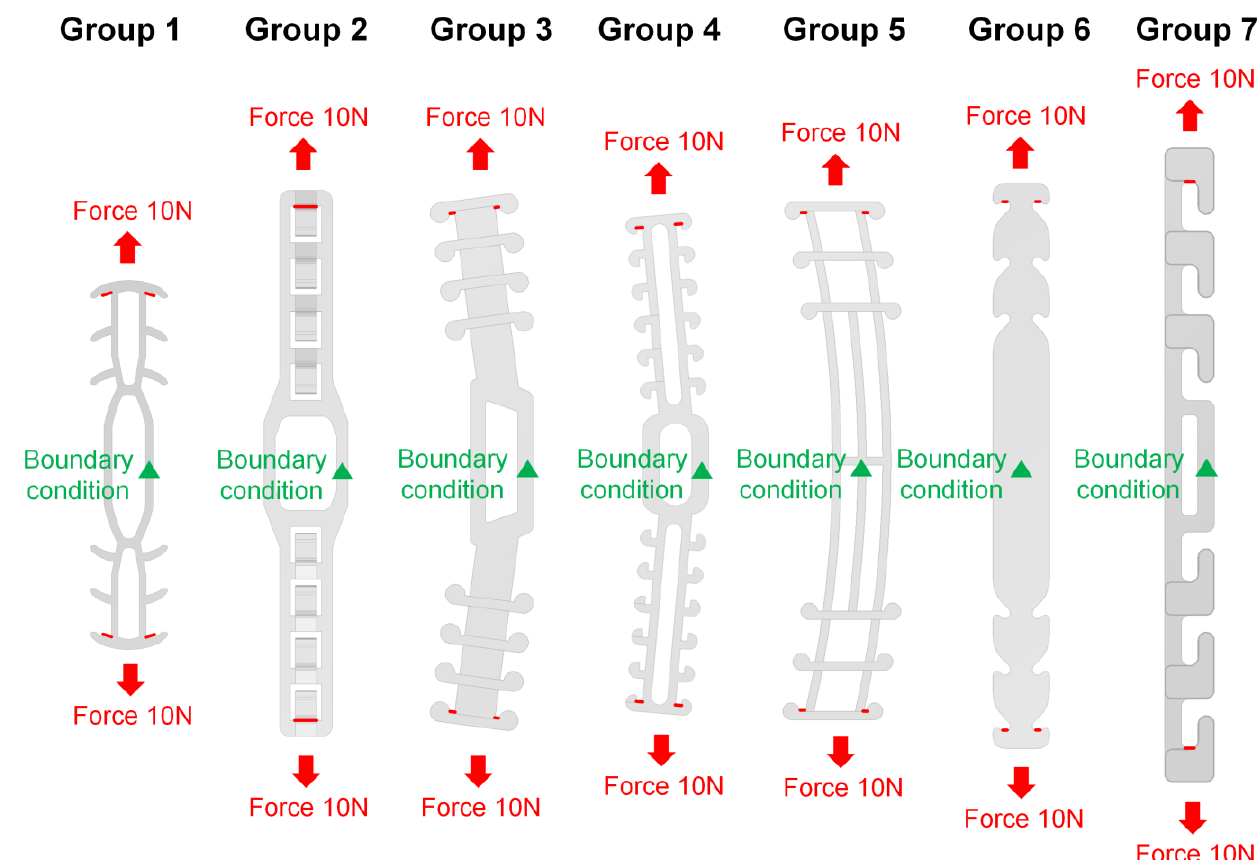
Figure 5. The boundary conditions and loading conditions for each group. Table 3. The number of nodes and elements after meshing in each group.